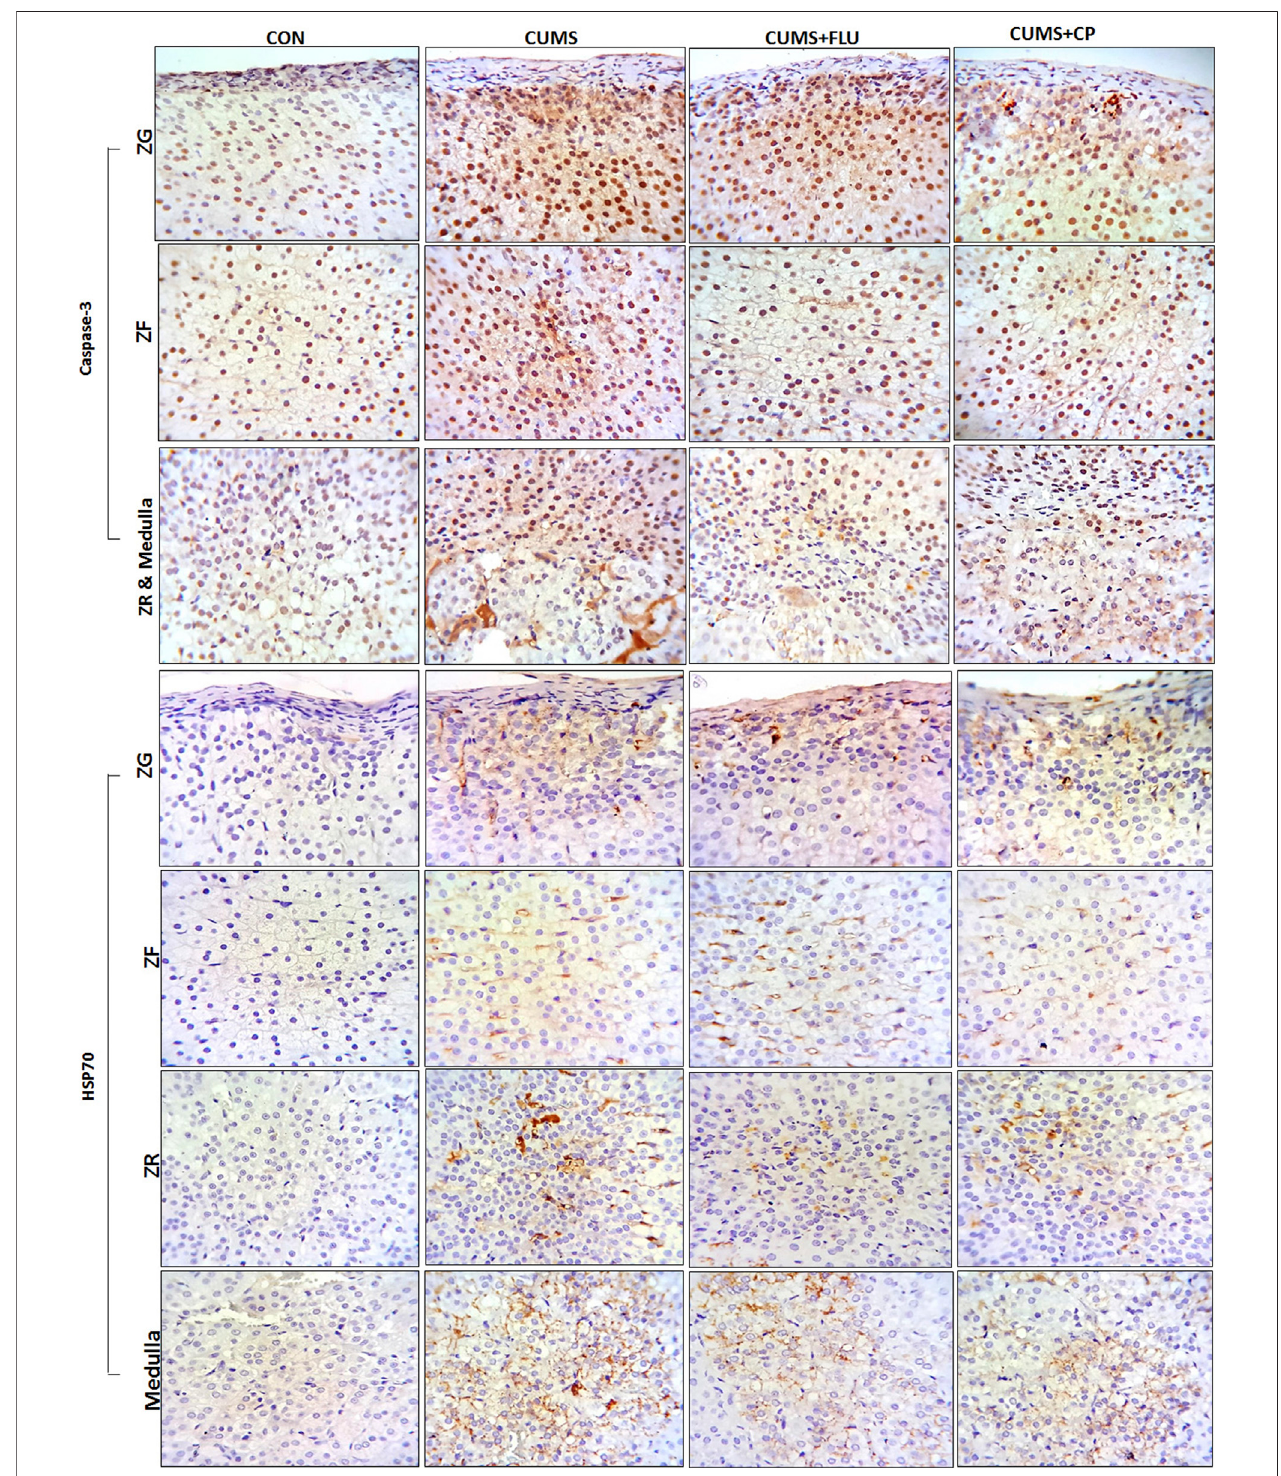
FIGURE 6 | Sections of the adrenal gland of studied groups stained immunohistochemically with caspase-3 and HSP70 antibodies. ZG: zona glomerulosa, ZF: zona fasciculata, ZR: zona reticularis. CON: control, CUMS: chronic unpredictable mild stress, Flu: fl uoxetine, CP: Cucurbita pepo .